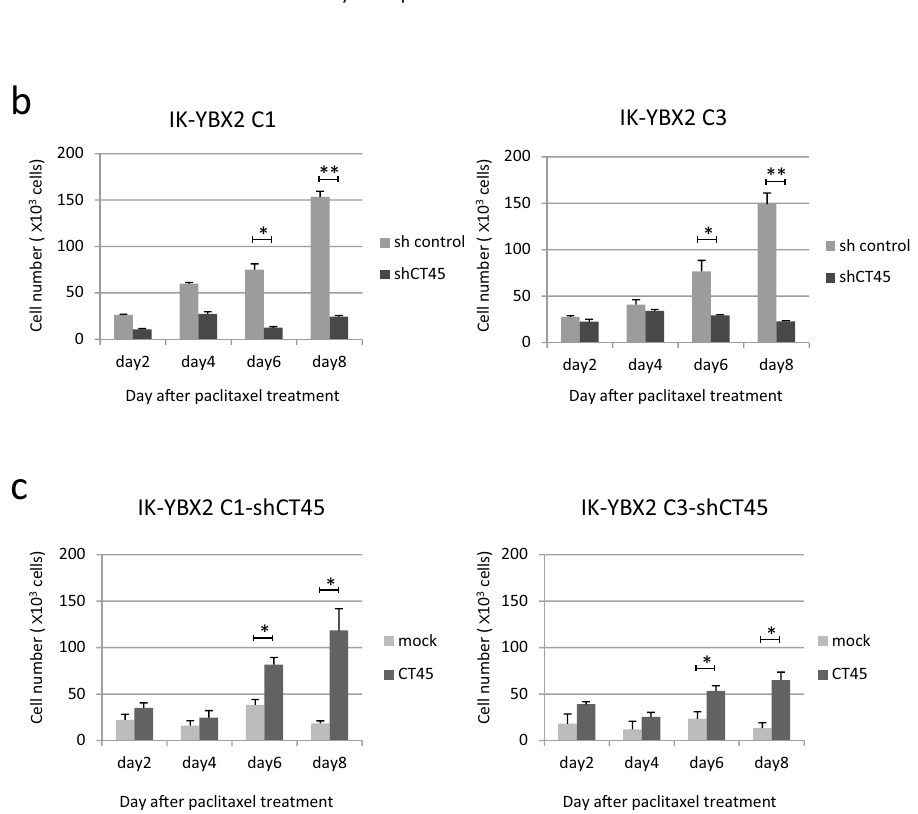
Figure 5. The expression of YBX2 and CT45 caused resistance to paclitaxel. ( a ) Chemosensitivity assay with IK-YBX2 C1 cells and IK mock cells. The number of IK-mock cells decreased over time after treatment with paclitaxel, while that of IK-YBX2 C1 cells was not changed. There were significant differences in the viable cell number at day 6 (* p < 0.05), and day 8 (** p < 0.01). ( b ) Chemosensitivity assay with IK-YBX2 C1 and C3-shCT45 cells and sh control cells was performed. The number of sh control cells increased over time. In contrast, the number of IK-YBX2-shCT45 cells decreased. There were significant differences in the viable cell number at day6 and day8 (* p < 0.05, ** p < 0.01). ( c ) Chemosensitivity assay with IK-YBX2-shCT45-CT45 rescued cells and mock cells. Similar to IK-YBX2 cells, CT45-rescued cells displayed the stronger resistance to paclitaxel. There were significant differences in the viable cell number at day6 and day8 (* p < 0.05). Data represent the means ± SD from three independent